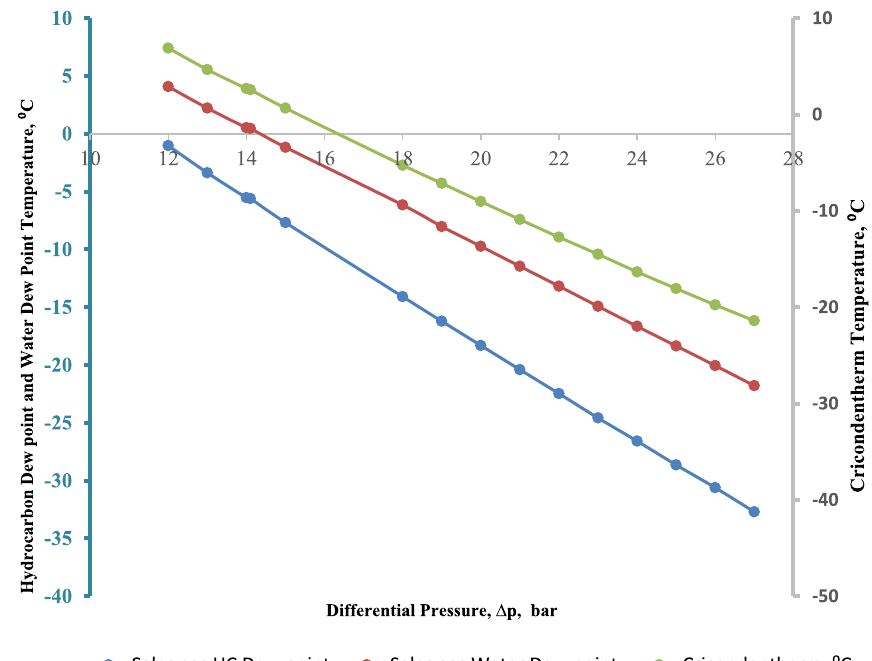
Fig. 2 Effect of (J–T) valve differential pressure (∆p) on hydrocarbon dew point, water dew point, and cricondentherm using composition of natural gas,